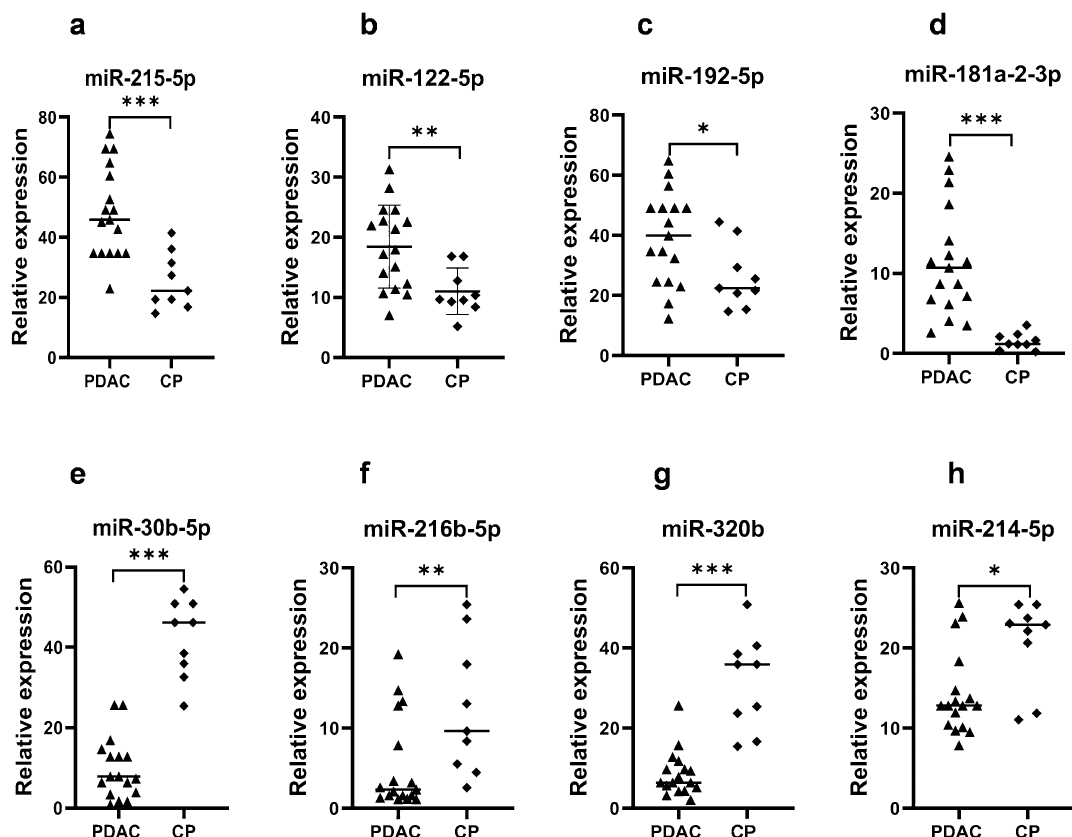
Figure 1. Relative expression of miRNAs in PDAC FFPE tissue samples compared with that in CP FFPE tissues. ( a – d ) Up-regulated miRNAs. ( e – h ) Down-regulated miRNAs. *p < 0.05, **p < 0.001, ***p <